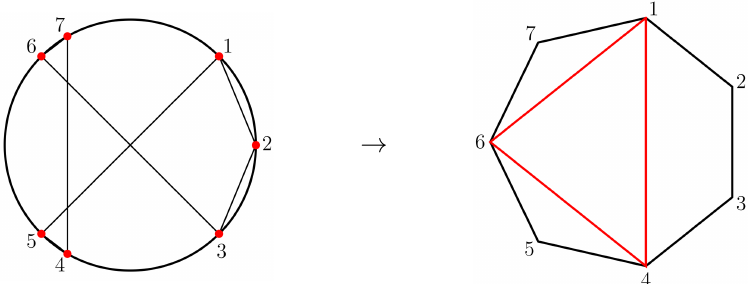
JHEP07(2021)111 (1547632) = 7